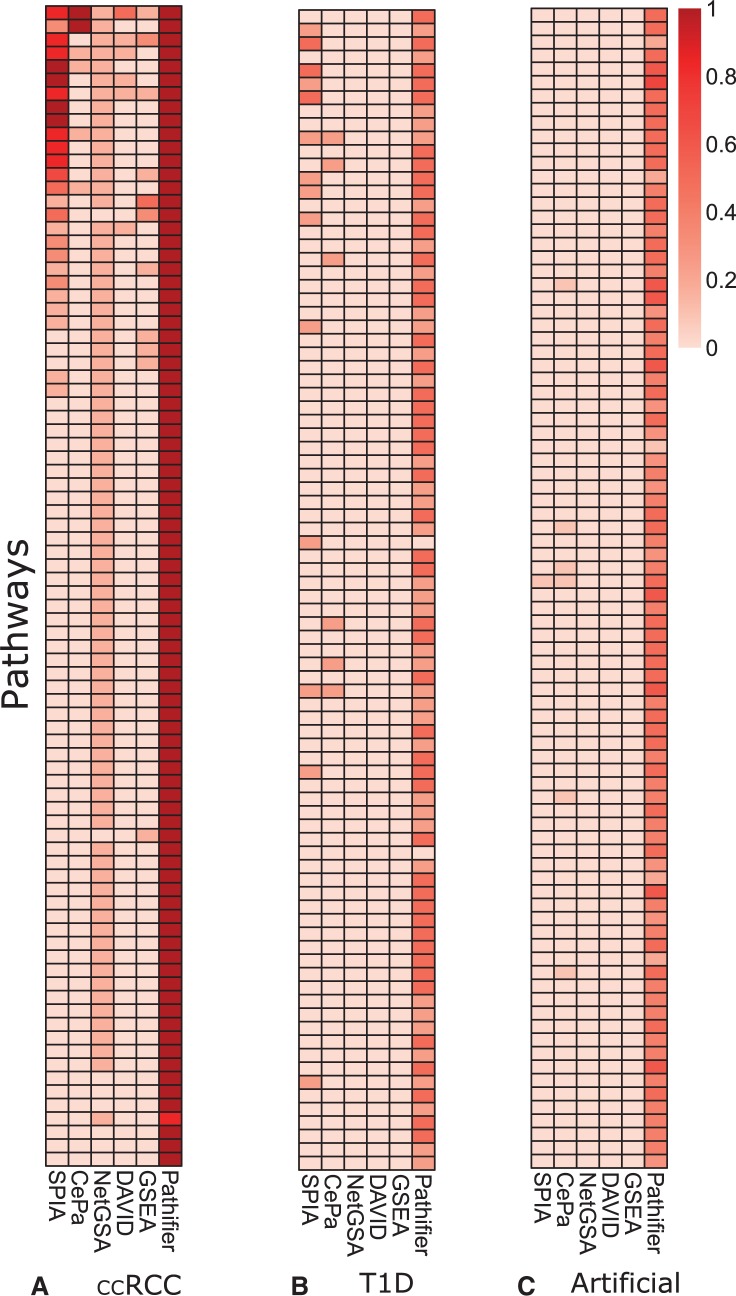
Consistency of the significant pathways (rows) identified using the six different tools (columns) in (A) six ccRCC data sets, (B) four T1D data sets and (C) 10 artificial data sets. The heatmap illustrates the percentages of data sets in which each pathway (row) is detected as significant. In artificial data sets, no consistent findings are expected. A colour version of this figure is available at BIB online: http://bib.oxfordjournals.org.